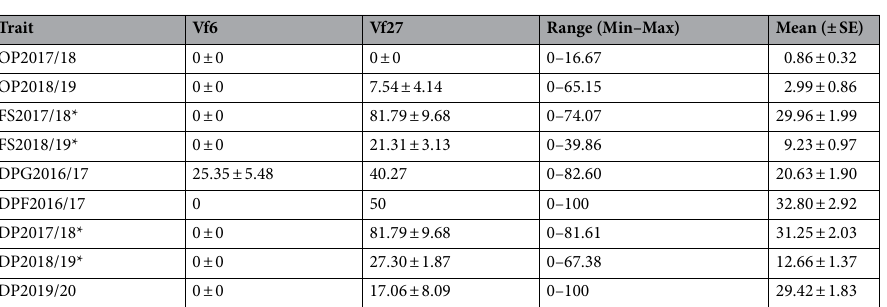
Table 1. Phenotypic values of completely opened pods (OP), fissured pods (FS) and dehiscent pods in greenhouse (DPG) or field (DPF) for the parental lines and the RIL population Vf6 x Vf27 in 2016/17, 2017/18, 2018/19 and 2019/20. Significant differences between parental lines ( P ≤ 0.05) are indicated by asterisks.